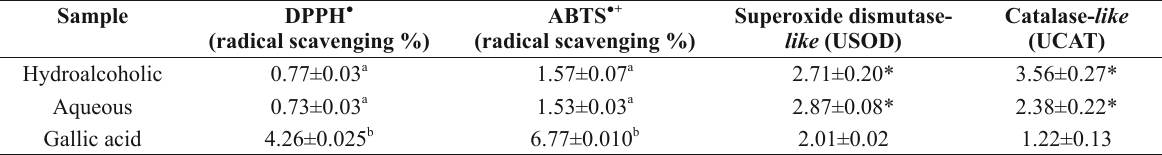
In vitro antioxidant activity, DPPH • , ABTS •+ , superoxide dismutase- like and catalase- like activities in Salvia of fi cinalis (L.) hydroalcoholic and aqueous extracts.